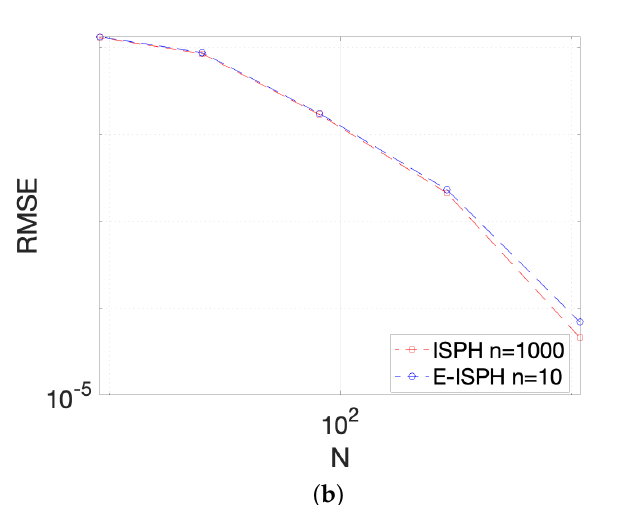
Figure 5. Comparison between ISPH and E-ISPH. ( a ) Time (s) versus number of data sites; ( b ) RMSEs versus number of data sites. All the computations are with starting normalized values, Ξ H as data sites, n = 1000 for ISPH and n = 10 for